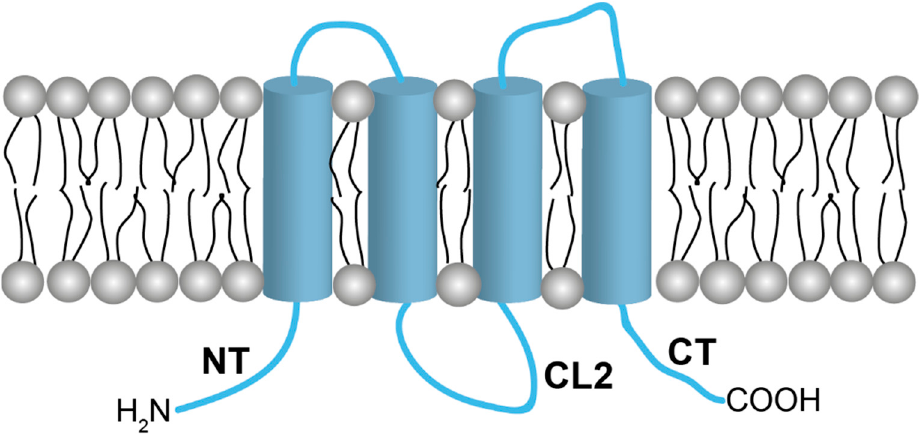
Figure 1. Topological schematic of a gap junction Cx.